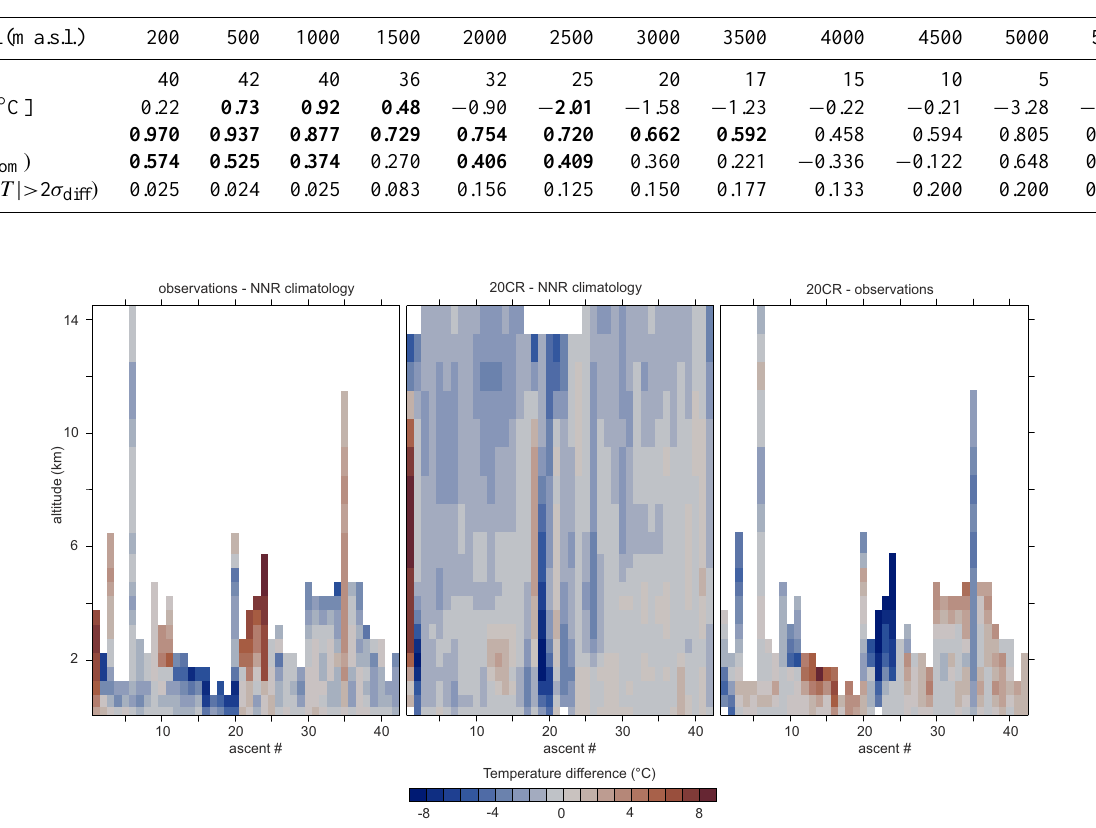
Fig. 2. Temperature profiles from observations and 20CR for the cruise of the SMS Planet . (left) Anomalies of observations with respect to NNR climatology, (middle) anomalies of 20CR with respect to NNR climatology, (right) difference 20CR minus